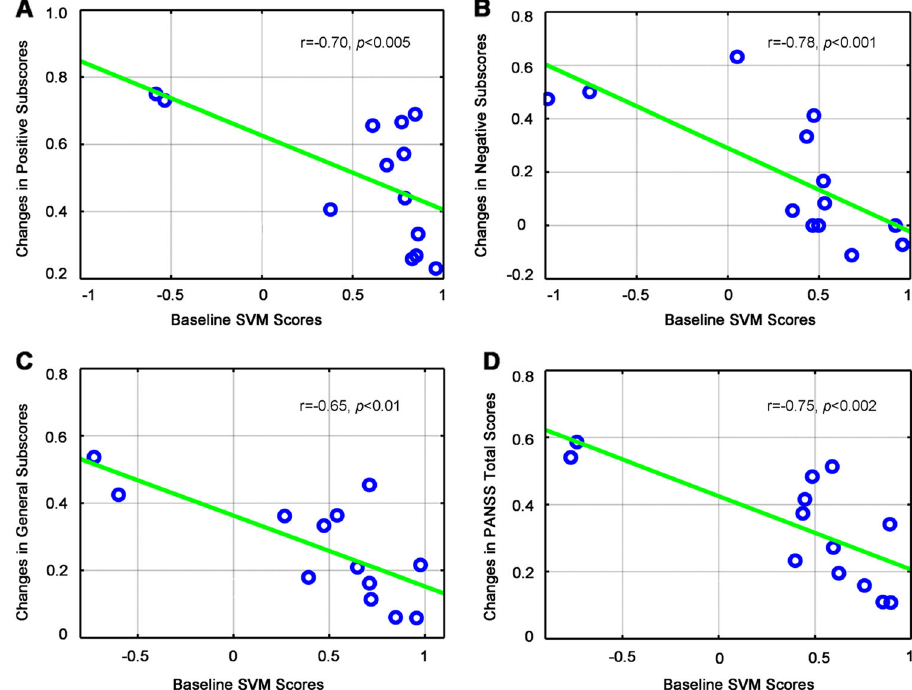
Fig. 4 Relationship between baseline classi fi cation scores and change in treatment response over the courses of ECT (after controlling for age, gender, years of education, and length of illness). Scatterplots show baseline SVM scores were negatively correlated with the symptom improvement as measured by PANSS positive subscores ( a ), PANSS negative subscores ( b ), PANSS general subscores ( c ), and PANSS total scores ( d ). ECT electroconvulsive therapy, SVM support vector machine, PANSS positive and negative syndrome